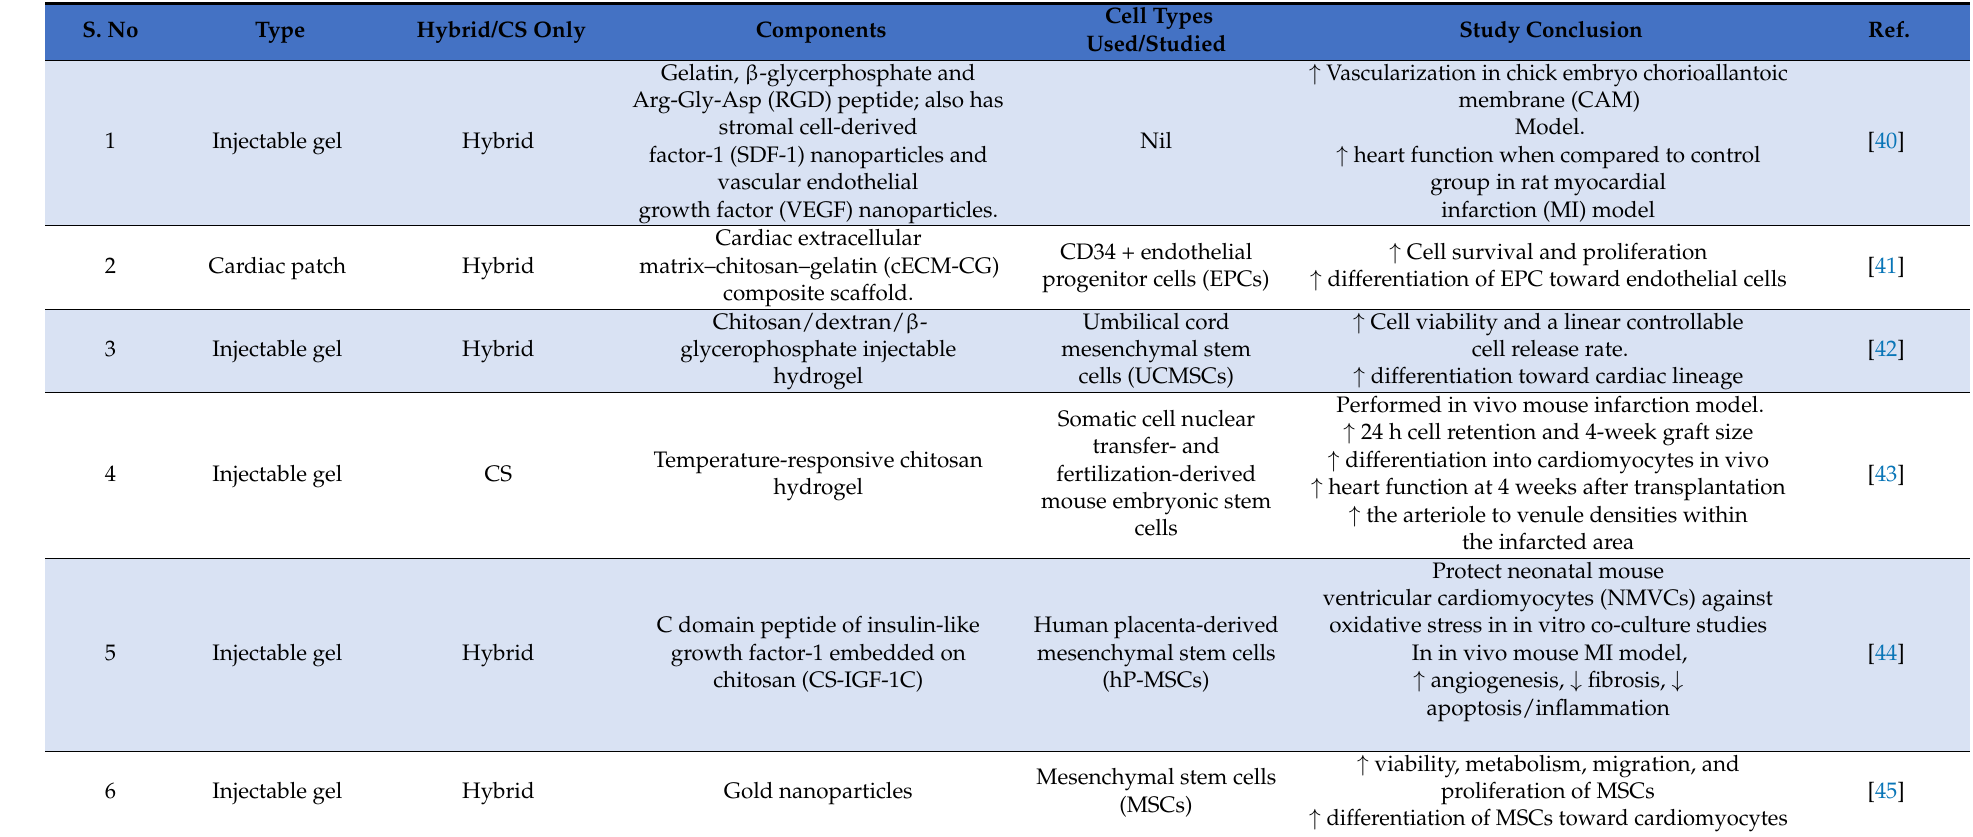
Table 1. List of various drug delivery systems designed using chitosan along with composition and their significant findings and use in cardiac therapies. [ ↑ indicates increase effect and ↓ decrease effect,